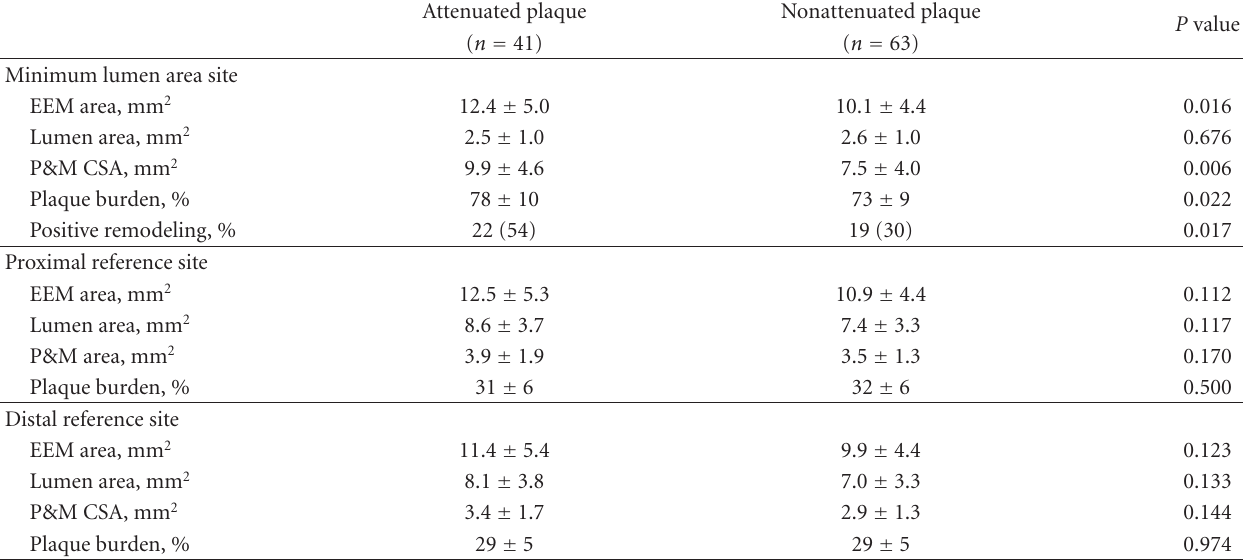
Table 2: Intravascular ultrasound